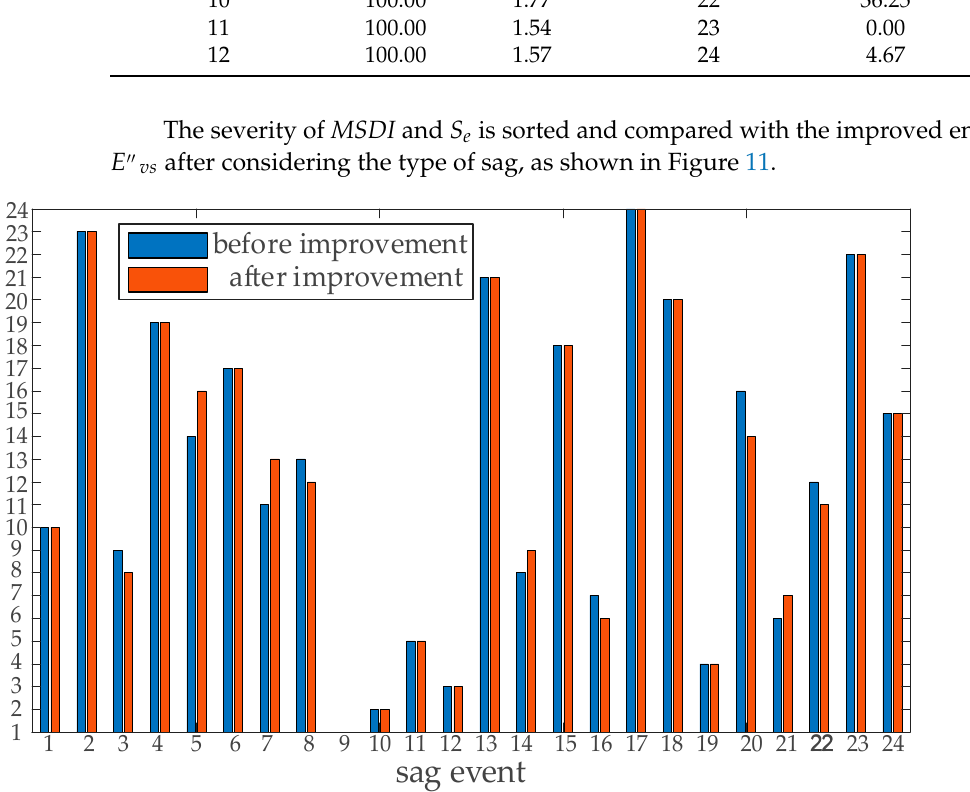
Figure 11. Comparison of severity ranking results under different evaluation indicators. Figure 10. Severity ranking comparison before and after improvement based on energy index.